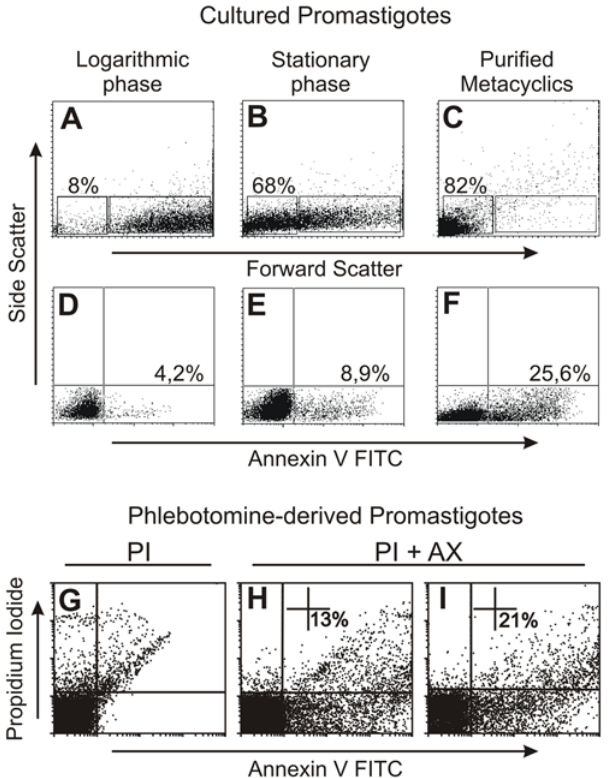
Figure 1. A fraction of metacyclic promastigotes exposes phosphatidylserine invivo and invitro . Characterization of small size (R2-lower left gate) and large size (R1-lower right gate) sub- populations of ( A ) logarithmic, ( B ) total stationary, and ( C ) purified metacyclic promastigotes, showed by dot-plots of forward light scatter (FSC) vs. side angle light scatter (SSC) obtained by flow cytometric analysis. PS exposure, assessed by AnV staining in ( D ) logarithmic, ( E ) total stationary, and ( F ) infective metacyclic populations. Figure displays one representative experiment out of five with similar results. PS exposure in promastigotes purified from the gut of Lutzomya longipalpis at ( H ) 5 days and ( I ) 9 days after artificial feeding with J774 cells infected with La and ( G ) the appropriate control parasites stained with PI only. Figure displays one experiment out of two with similar